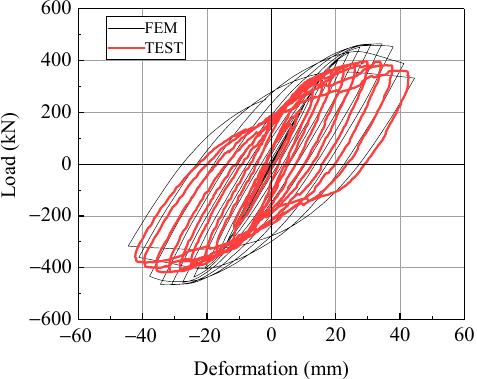
Figure 8. Loading pattern I. Figure 9. Load-deformation of specimens obtained by experiment and finite element model.